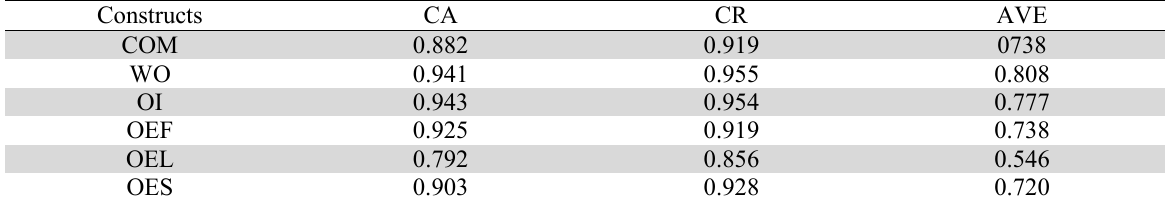
Findings of the measurement model (First-Order, Reflective) Constructs